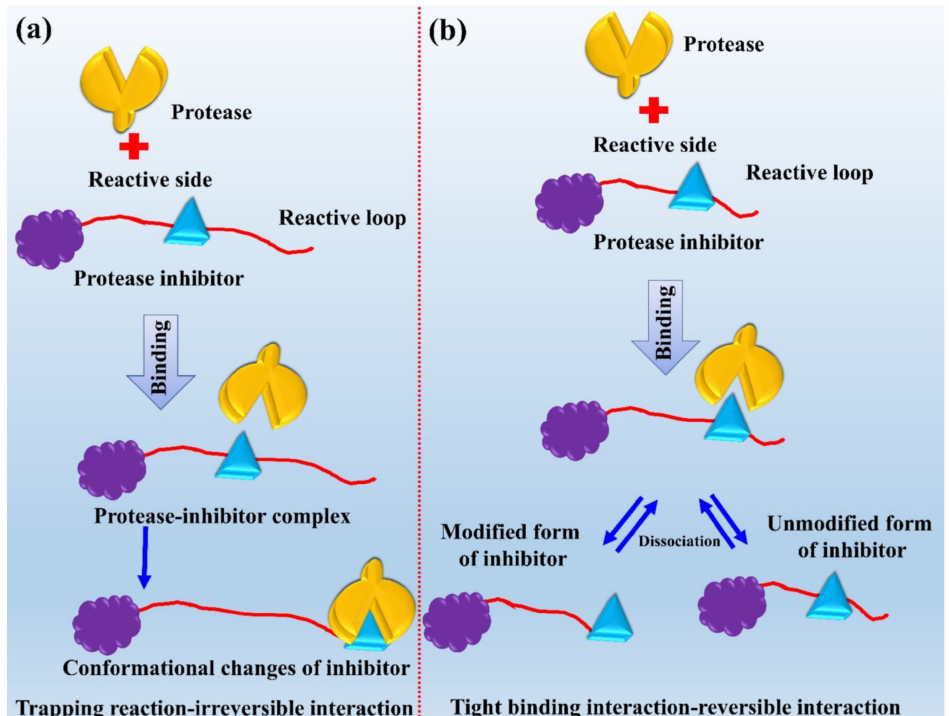
Figure 8. Mechanism of action of fungal protease inhibitors. ( a ) Trapping reaction-irreversible interaction and ( b ) Tight binding interaction-reversible interaction. This figure is reproduced from Rudzinska et al. [216] (Attribution-NonCommercial 3.0 Unported, CC BY-NY